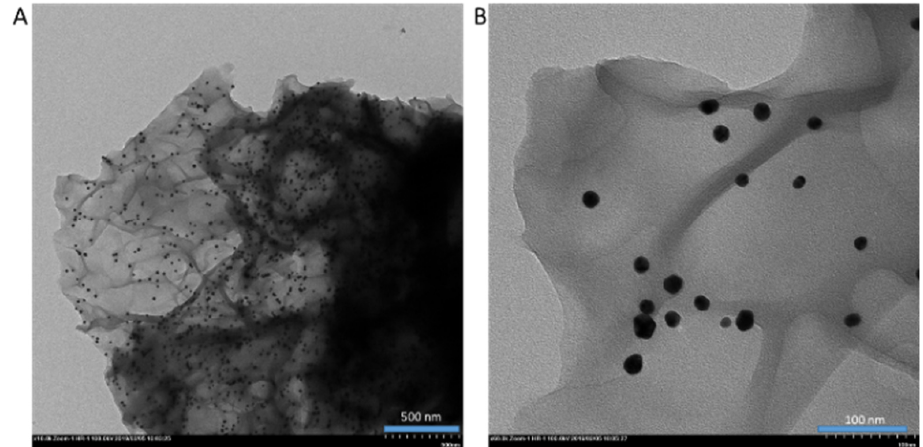
Figure 7. TEM micrographs of the aqueous layer after completion of the reaction. (( A ) 10.0 k zoom. ( B ) 60.0 k zoom).